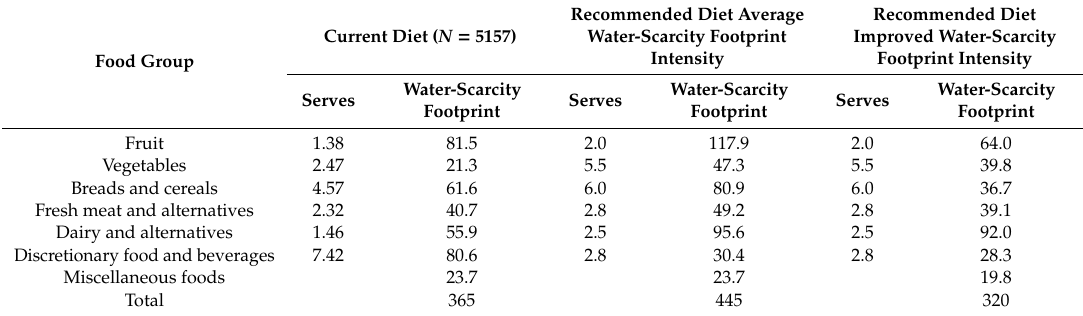
Table 3. Dietary intake (serves person − 1 day − 1 ) and water-scarcity footprint (L-eq person − 1 day − 1 ) for the current and recommended Australian adult (19–50 years) daily diets 1